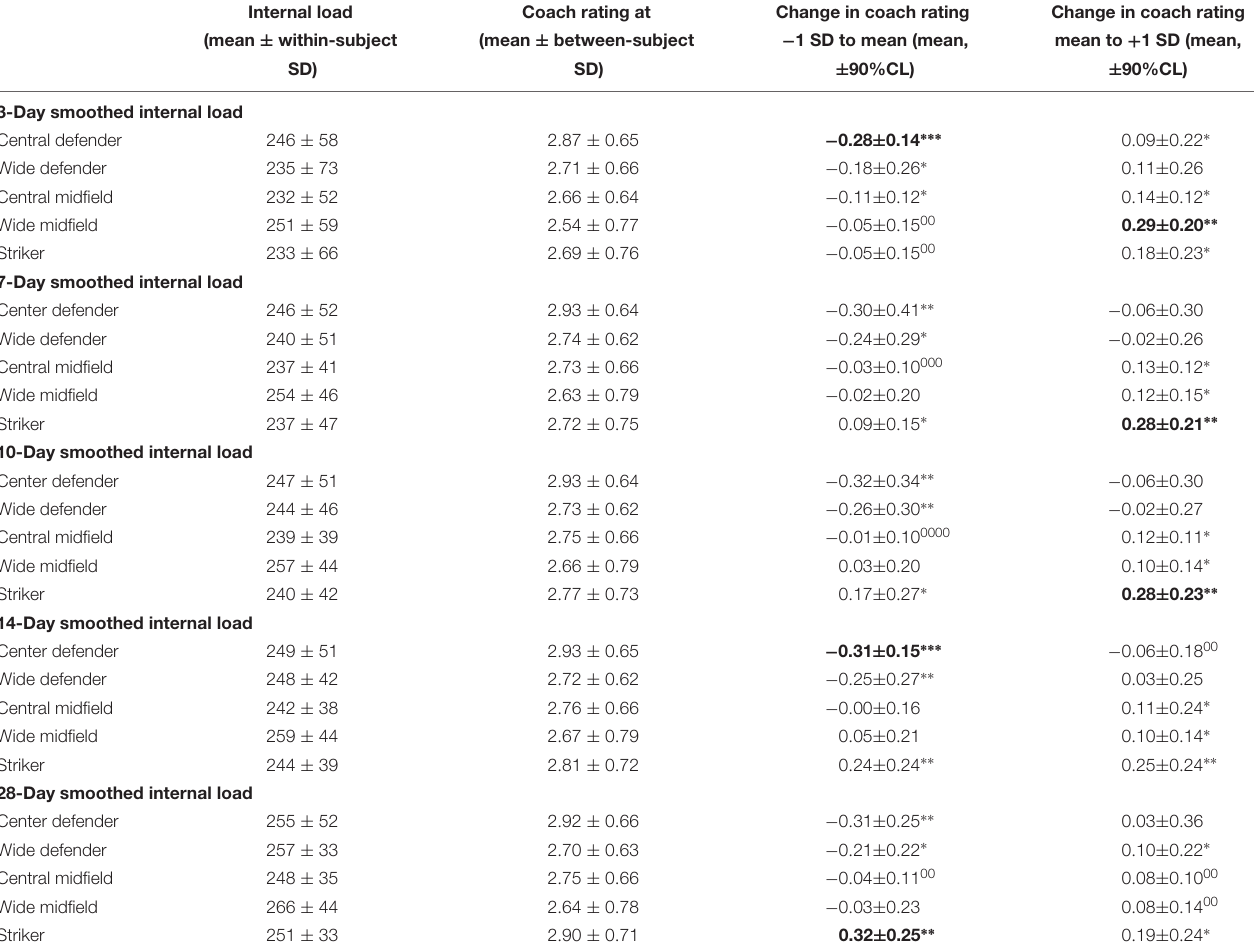
TABLE 1 | Mean internal load across each smoothed time window and the corresponding coach rating in each positional group. Internal load Coach rating at Change in coach rating Change in coach